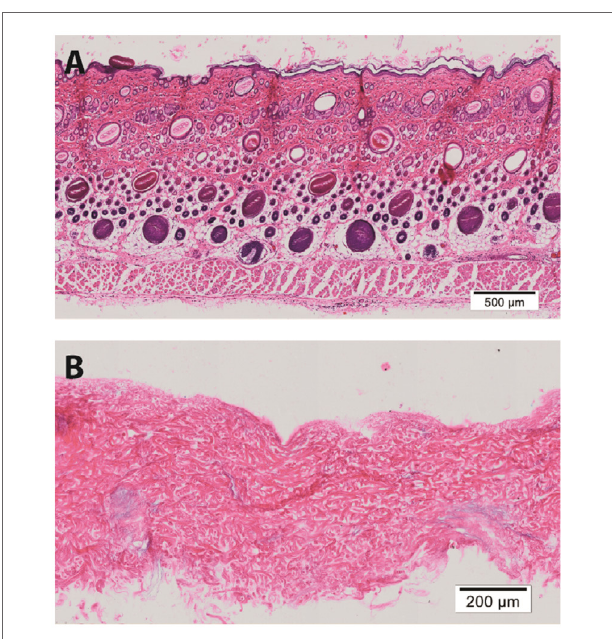
FigUre 1 | histology of processed rat skin. Representative figures of H&E of full thickness rat skin (a) and a preparation of rat acellular dermal matrix (ADM) (B) . This rat ADM preparation shows the removal of the epidermis and lack of cells in the dermal layer. The histoarchitecture of the dermis of ADM is comparable to fresh skin. Scale bars as indicated. Magnification: 10 ×